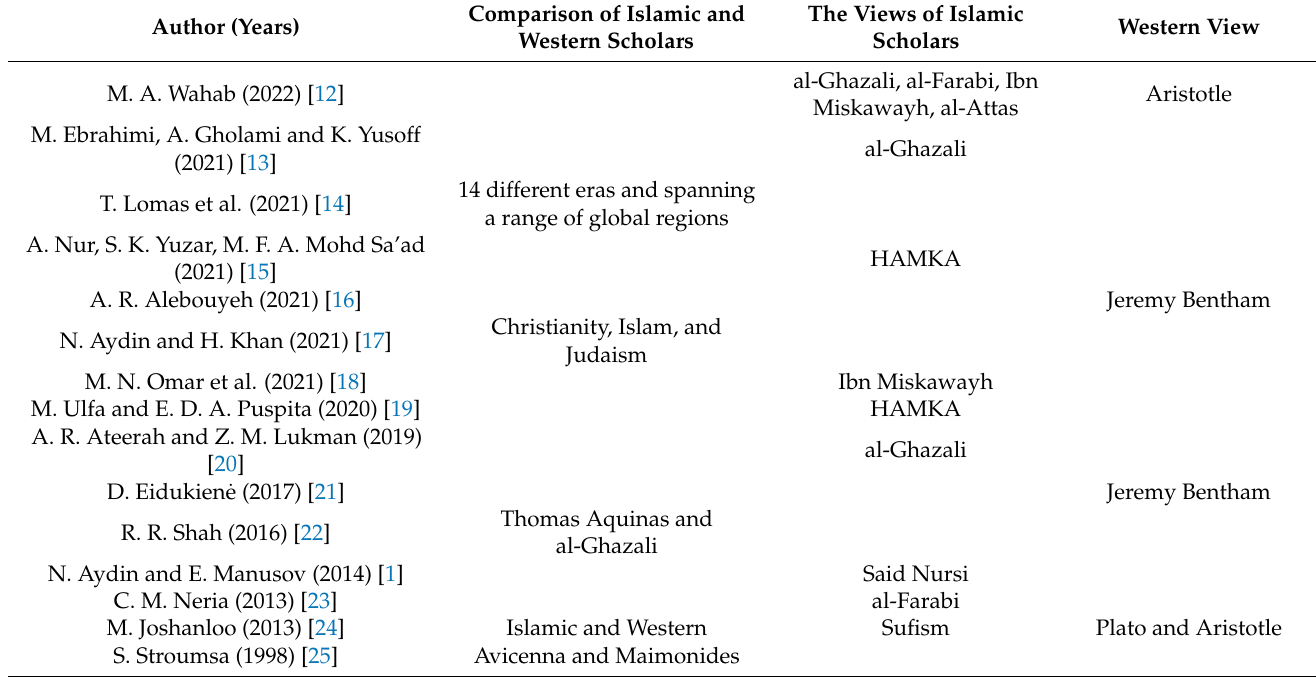
Table 4. Figures that highlight the debate on the topic of happiness discussed by selected